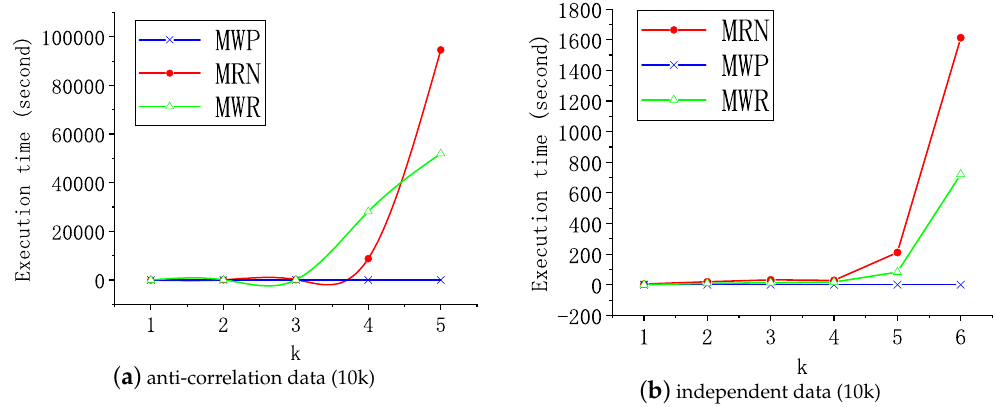
Figure 9. Runtime for MWP, MRN and MWR algorithms, where w ∈ R .